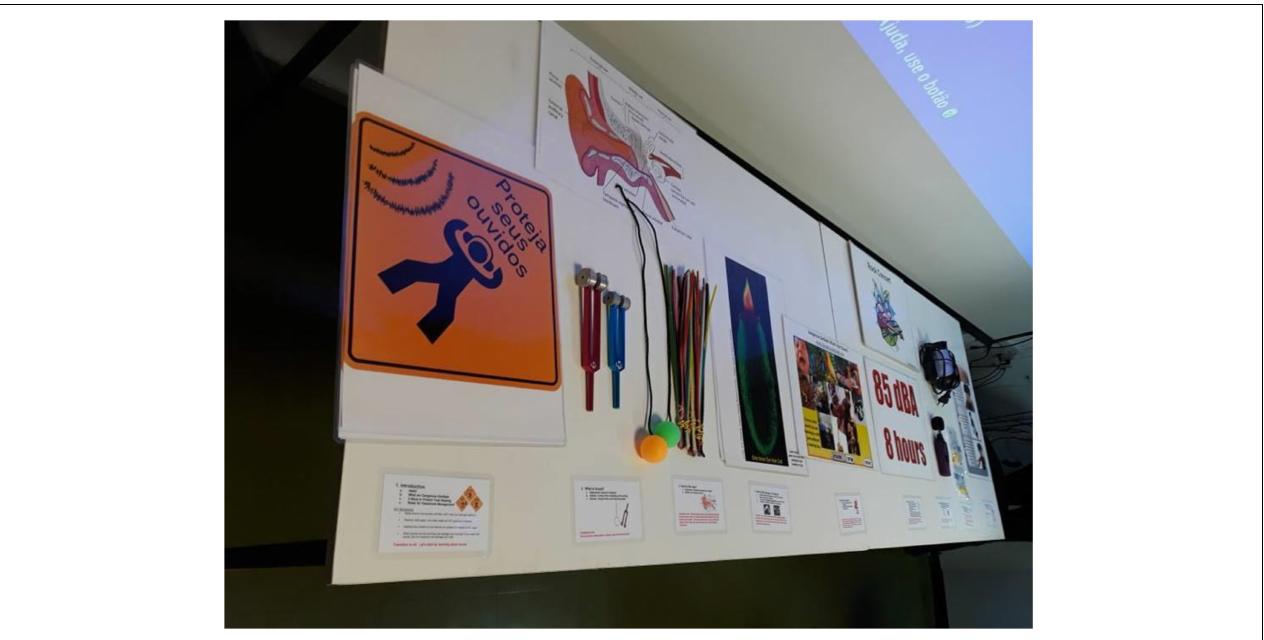
FIGURE 1 | Summary version of the script DDBEI and educational